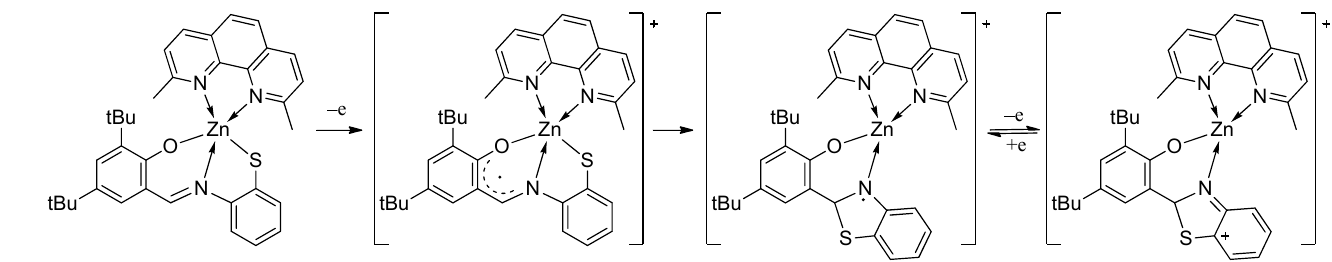
radical (Scheme 4).